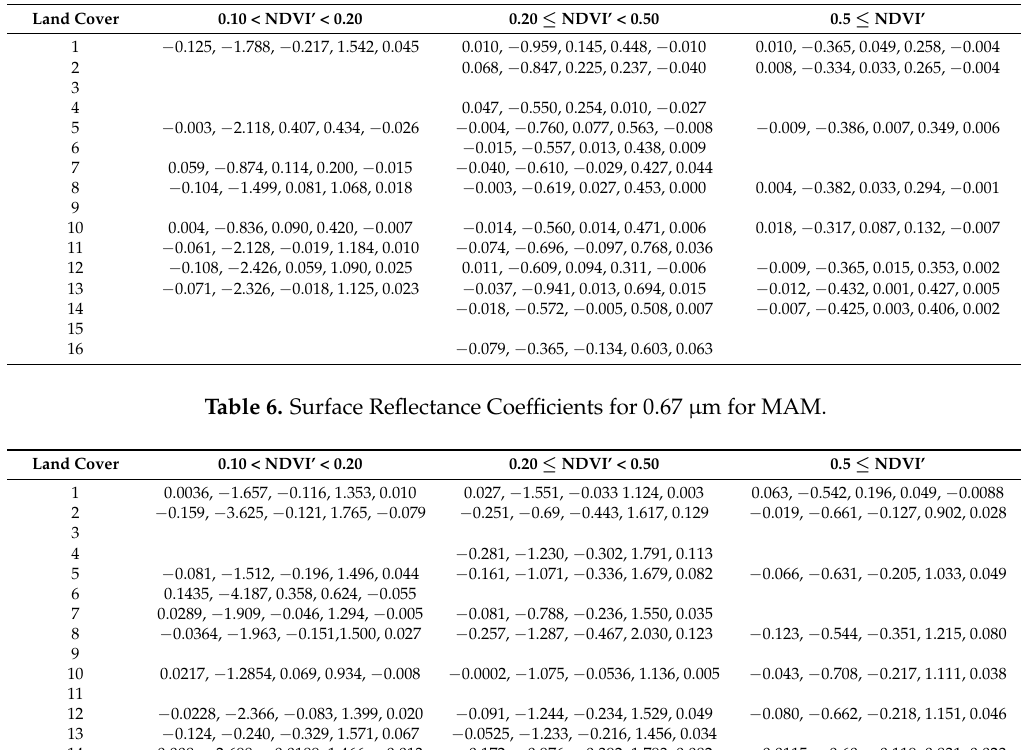
Table 5. Surface Reflectance Coefficients for 0.47 µ m for December-January-February (DJF).